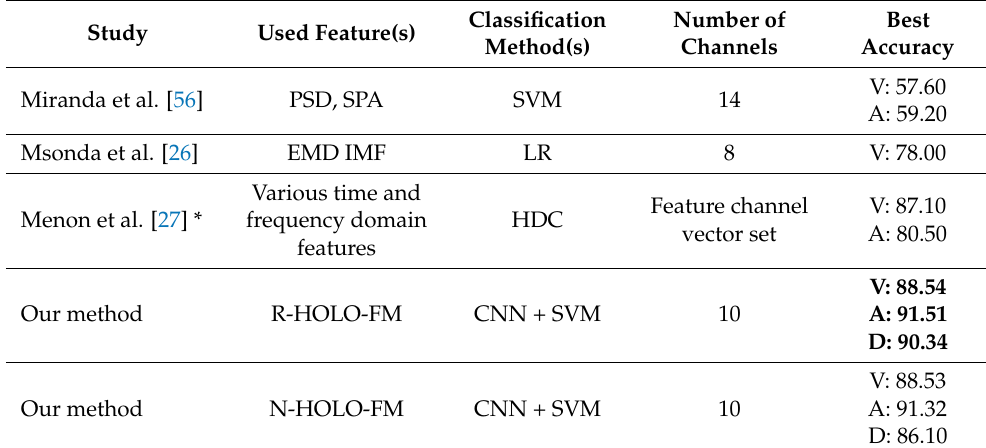
Table 6. Comparison with other studies with reduced channel set on AMIGOS dataset.